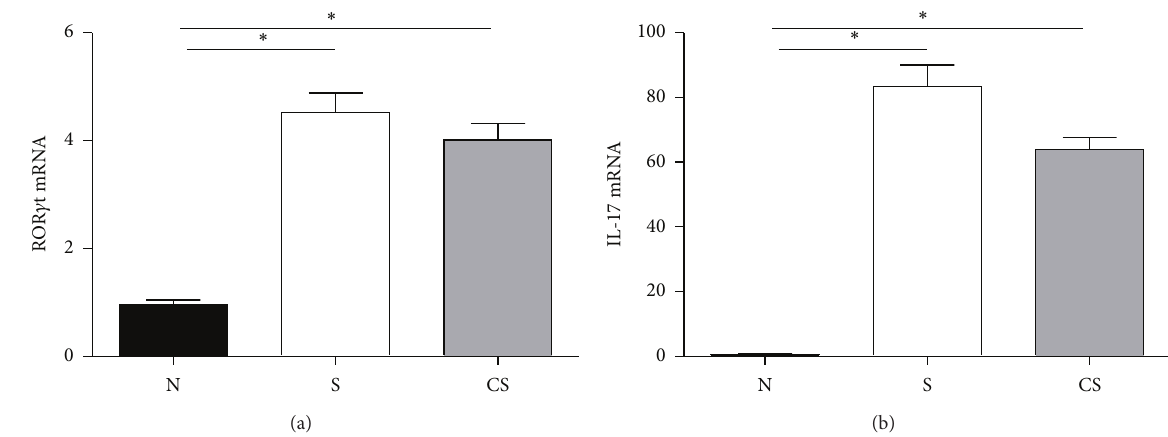
Figure 4: Elevated mRNA expressions of ROR 𝛾 t and IL-17 are not reversible after smoking cessation. The mRNA expressions of ROR 𝛾 t and IL-17 in lungs of nonsmoke mice, smoke-exposed mice, and smoke cessation mice were measured by using ELISA. (a) mRNA expressions of ROR 𝛾 t in lungs; (b) mRNA expressions of IL-17 in lungs. Results are expressed as mean ± SEM. 𝑛 = 10 animals/group; ∗ 𝑃 < 0.001